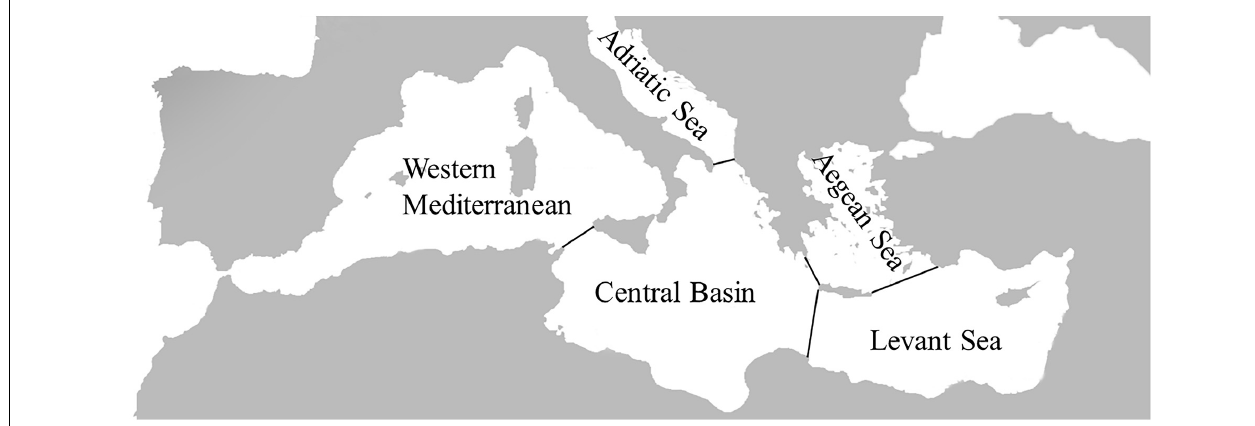
FIGURE 1 | Map of the Mediterranean Sea and the Zoogeographic zones within it considered in this study.